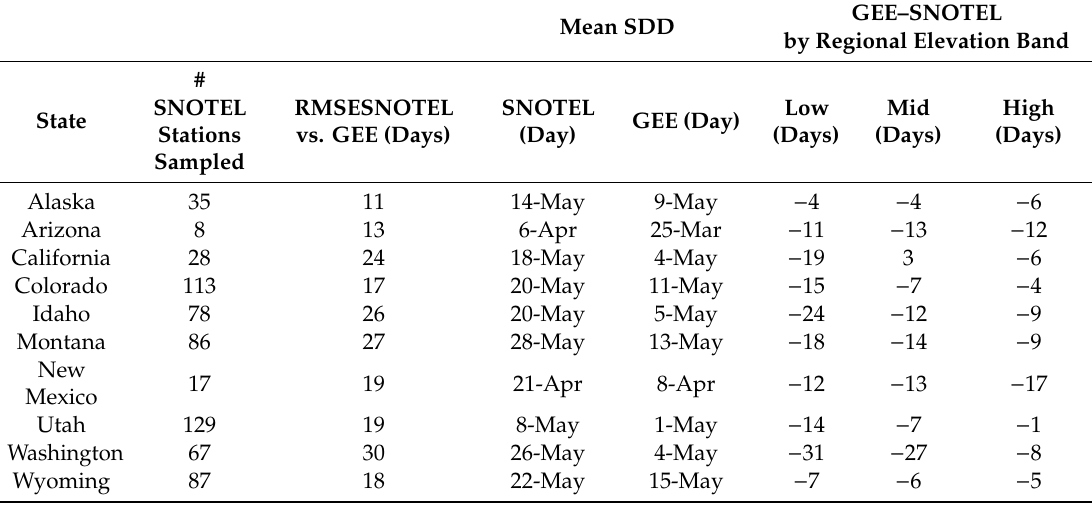
Table 2. SNOTEL derived Snow Disappearance Date (SDD) vs. GEE derived SDD by state ( n = 755). Dataset includes water years 2001 through 2018 for each state. The regional elevation bands were chosen by grouping the data into bands based on the 33rd and 66th elevation quantiles in each state.